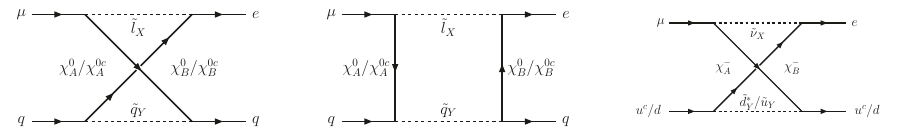
Figure 3. Box diagrams with neutralinos/antineutralinos and charginos. All indicated particles run in the direction of the arrows/from left to